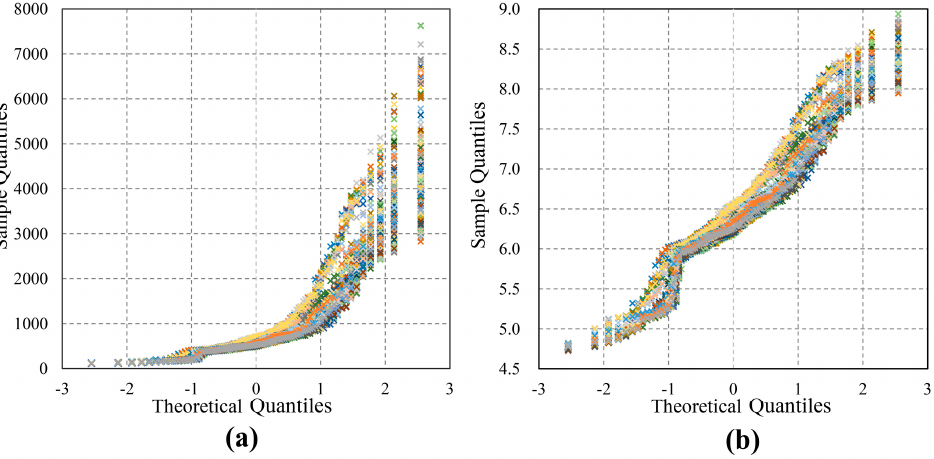
Figure 3. Normal probability plots of the original and Box ‐ Cox transformed runoff data at a lead time of 48 h: ( a ) original data; ( b ) Box ‐ Cox transformed data.